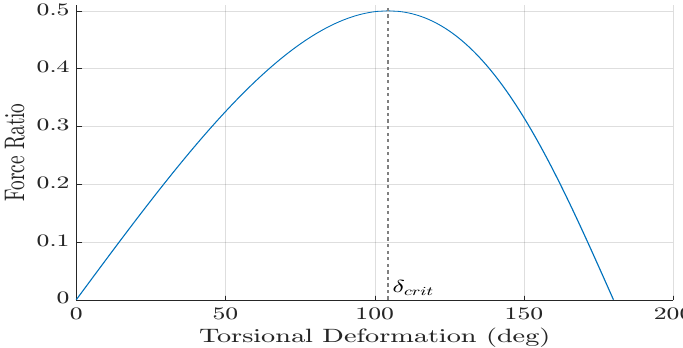
Figure 21. Force ratio against torsional deformation.